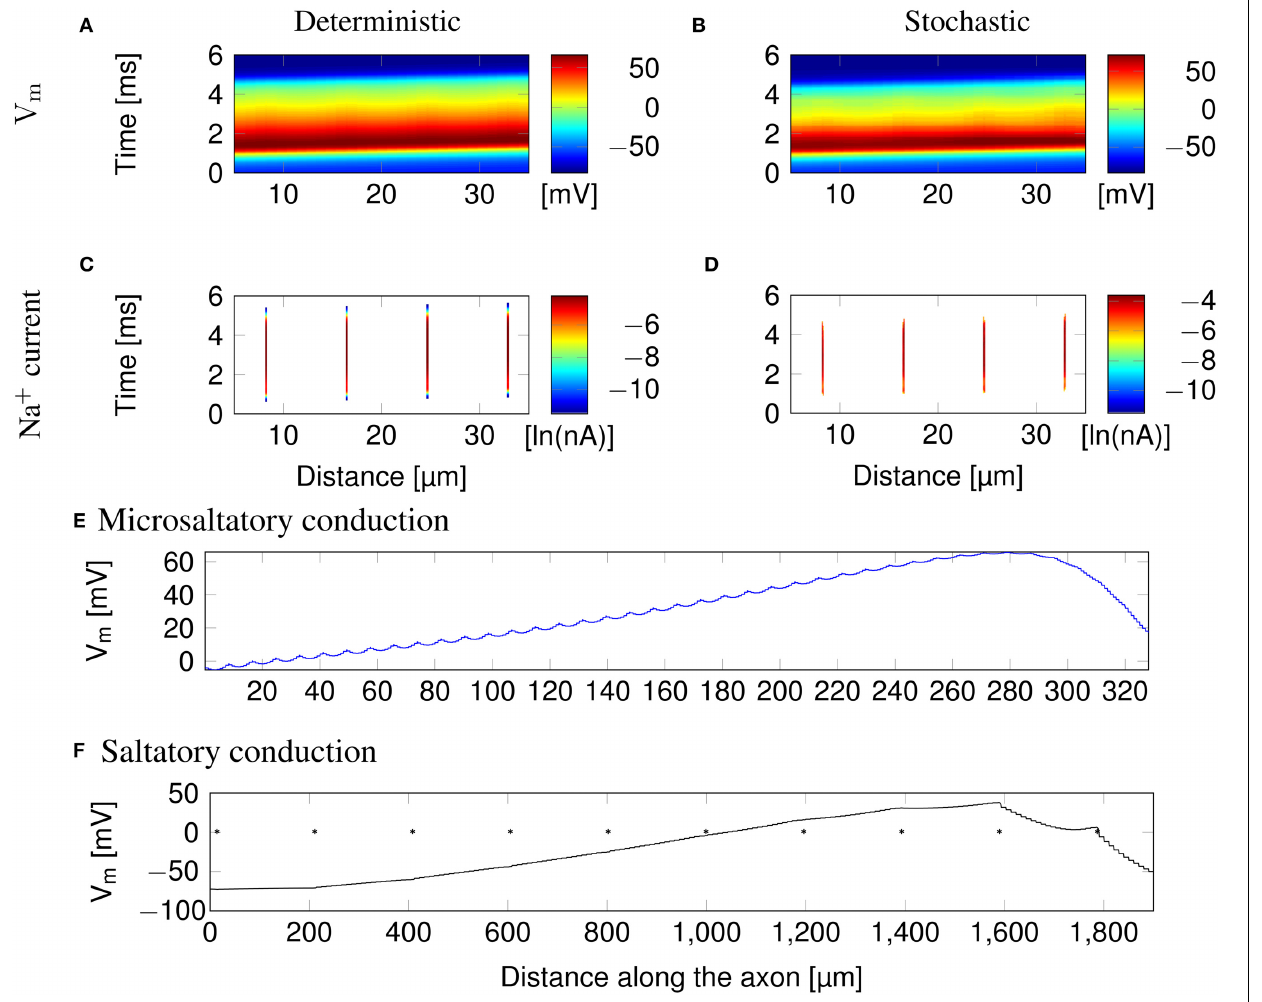
(E) Profile of the AP waveform propagating in a C-fiber axon. The bumps in the waveform correspond to the placement of lipid rafts. (F) Profile of the AP waveform in a model of mammalian myelinated axon (using parameters from McIntyre et al., 2002). The AP “jumps” between nodes of Ranvier, denoted by ∗ , but the amplitude is not heavily reduced over the